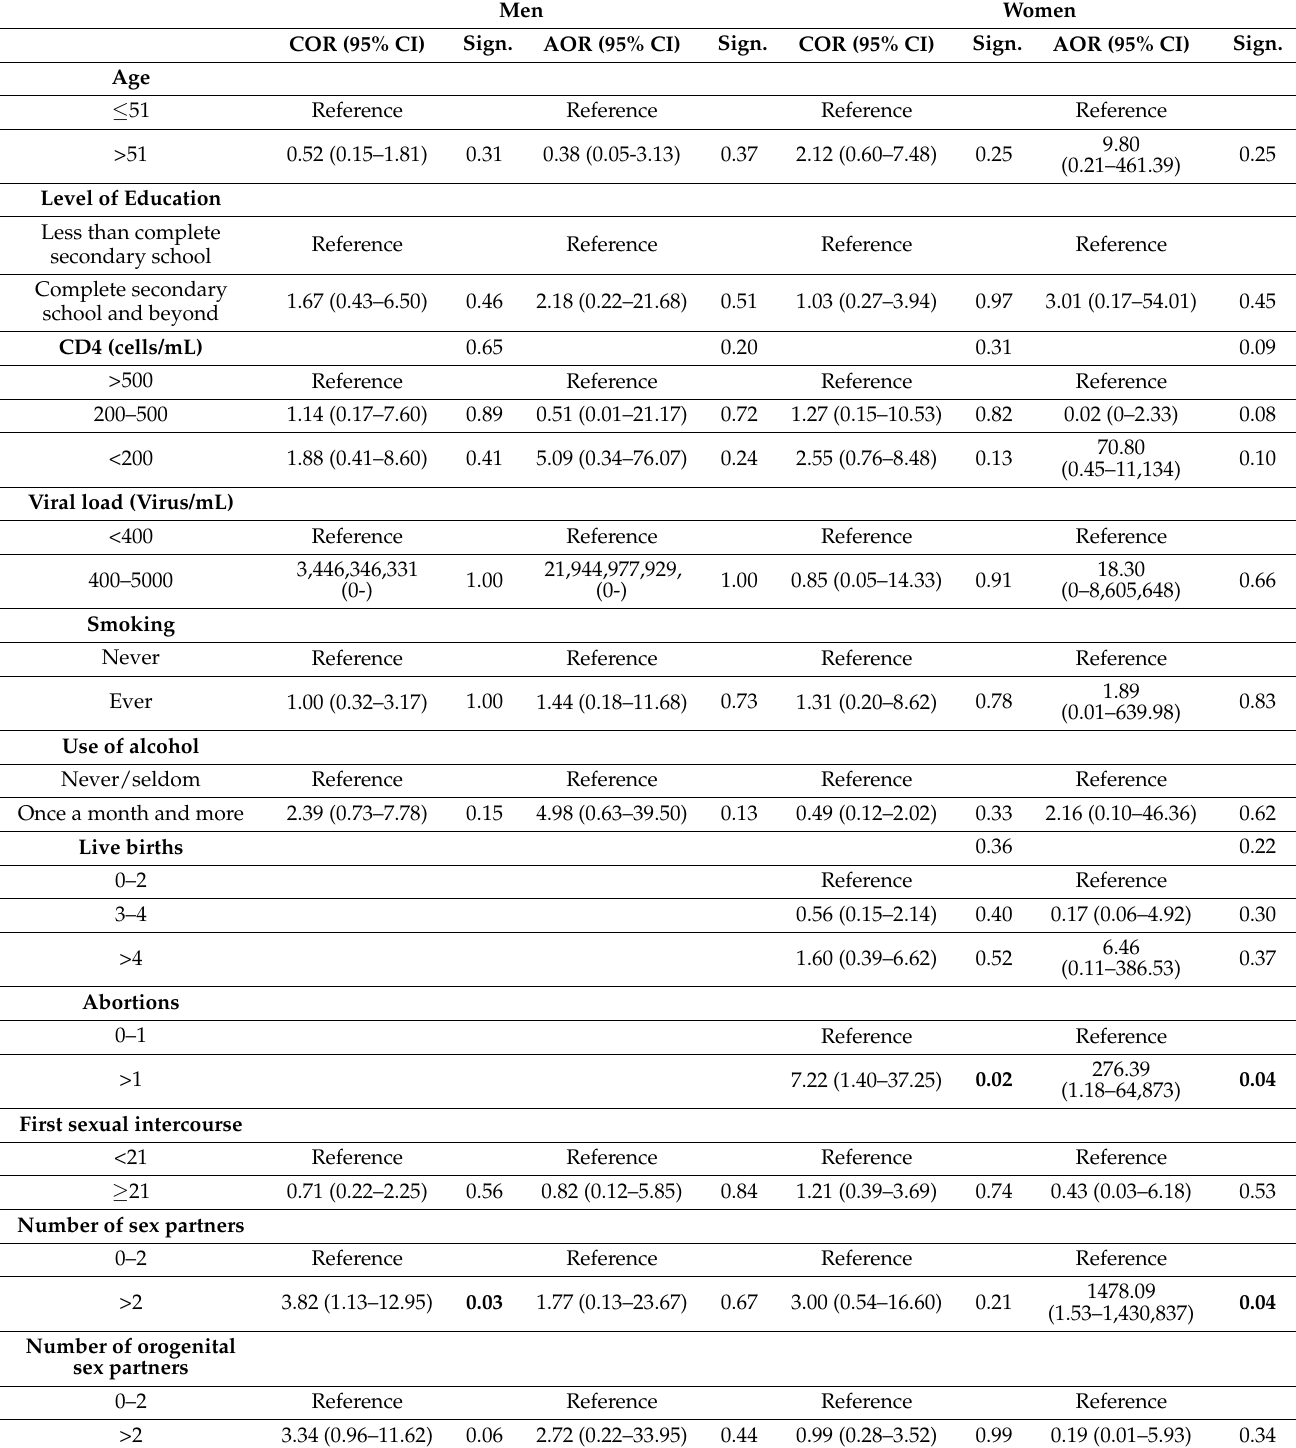
Table 5. Risk of HR-HPV infections in any mucous membrane in men and women. Men Women COR (95% CI) Sign. AOR (95% CI) Sign. COR (95% CI) Sign. AOR (95% CI)